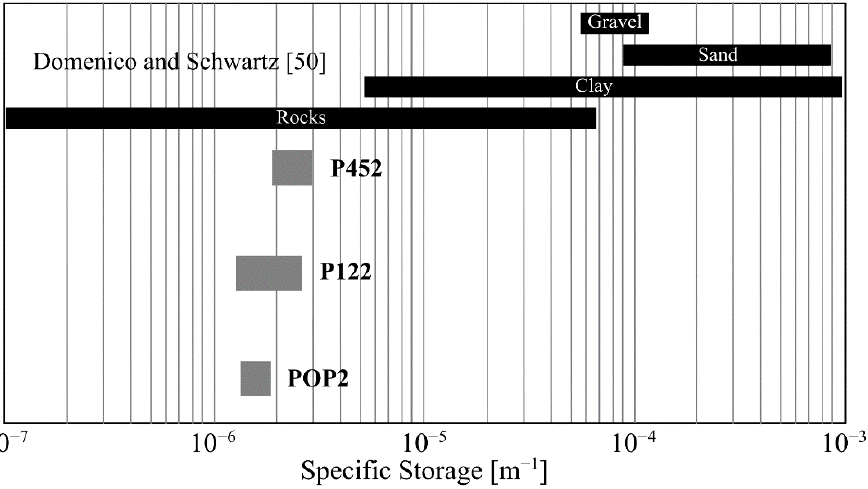
Figure 5. Comparison between the estimated specific storage values (P452, P122, and POP2) and the expected values as a function of the rock-material type.